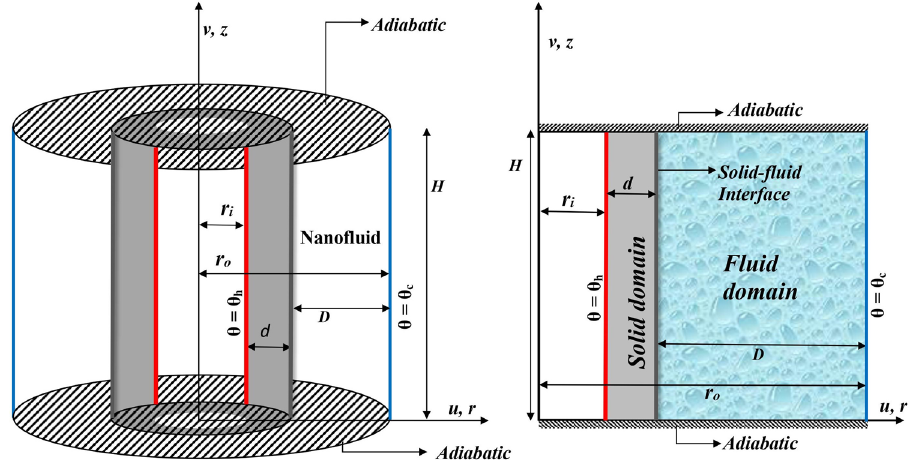
Figure 1. Physical model of conjugate natural convection in an annular geometry and the axi-symmetric view.